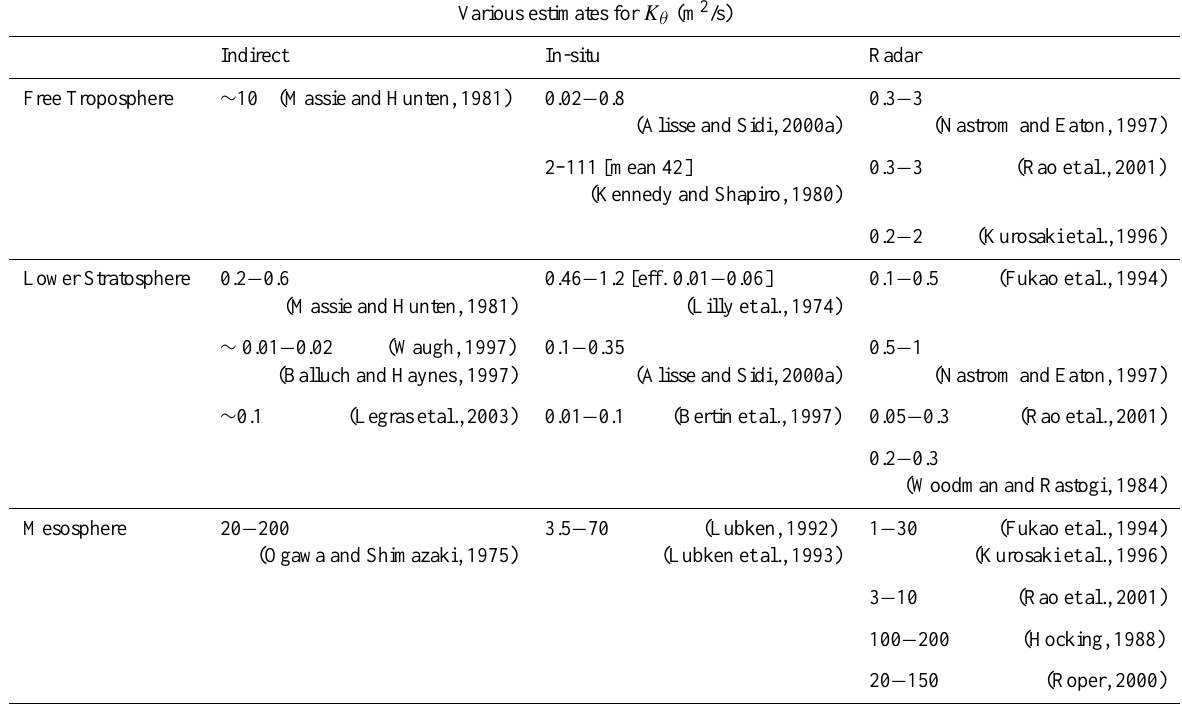
Table 1. Various estimations of atmospheric diffusivity (m 2 /s) for the UTLS and